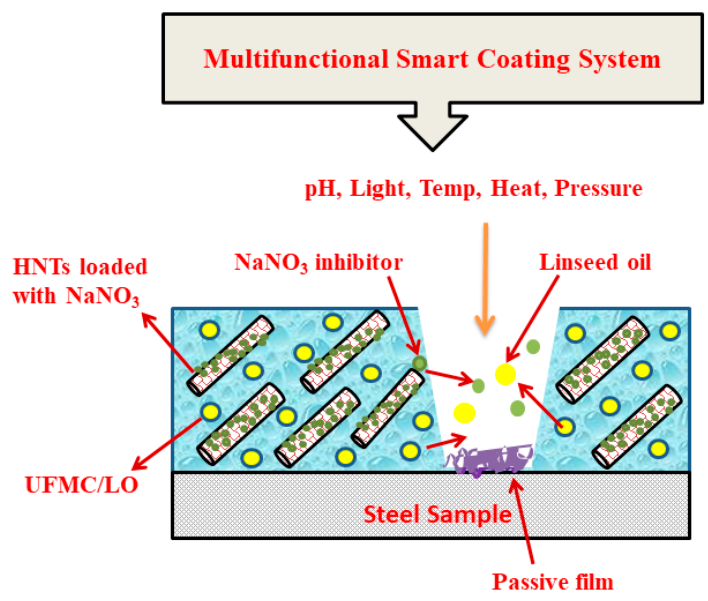
Figure 1. Schematic representation of multifunctional nanocomposite coating concept.